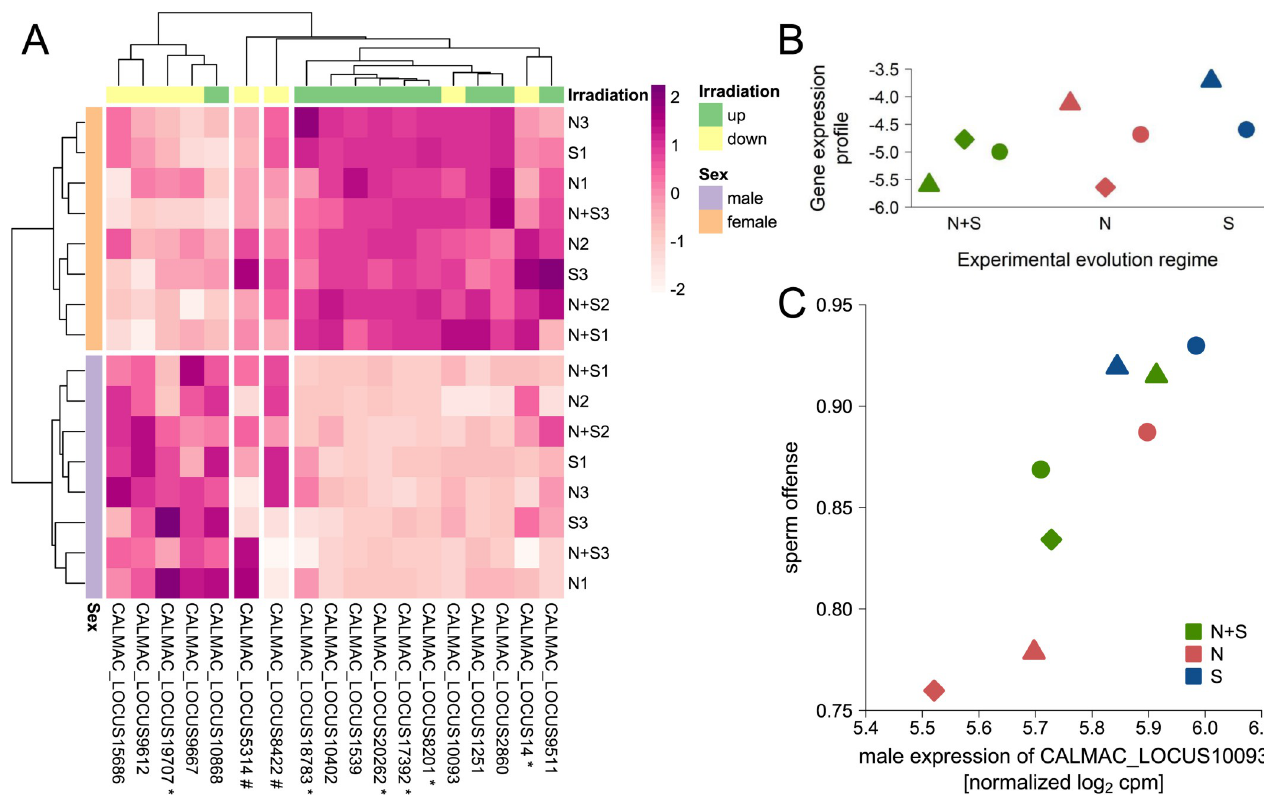
Fig 6. Expression of the 18 irradiation responsive genes in the 8 experimental evolution lines. ( A ) Heatmap of scaled normalized log 2 expression values. Samples are separated by sex (females: orange; male: purple) and genes are separated by sex bias, which roughly coincides with the direction of irradiation response (up-regulated: green; down-regulated: yellow). All but 2 genes (#) show a significant differential expression between males and females; 6 genes show a significant sex bias of at least 2-fold difference ( � ). Genes being up-regulated in response to irradiation tend to be female-biased (right block), while genes being down-regulated in response to irradiation tend to be male-biased (left block). ( B ) Scores (based on canonical coefficients used previously to separate control and irradiated samples) of male samples from the experimental evolution lines (24 h after a single mating). Higher scores indicate a more irradiation- like gene expression profile. ( C ) Positive correlation between normalized log 2 expression of the irradiation responsive gene CALMAC_LOCUS10093 (down- regulated in response to germline damage) and sperm offense (P2) ability of males from the experimental evolution lines. Experimental evolution regimes: N +S: natural and sexual selection; N: only natural selection; S: mainly sexual selection. Triangles refer to S1, N1, N+S1; diamonds refer to N2, N+S2; and circles refer to S3, N3, N+S3. The data underlying this figure can be found in “EE_Lines_Log2cpm_IrradiationGenes.txt” and “P2_line_estimates.txt” at Mendeley Data (http://dx.doi.org/10.17632/szyb2z8rzk.1).